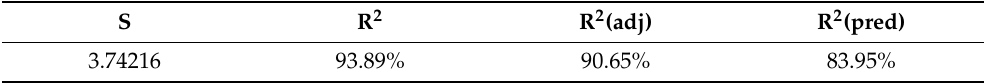
Table 4. Analysis of variance of NE selectivity.